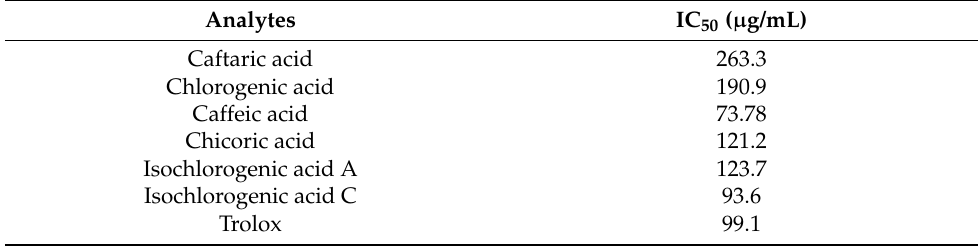
Figure 9. The verification results of each ingredient and positive drug (Trolox). Table 6. IC 50 values ( μ g/mL) of of each ingredient and positive drug (Trolox).